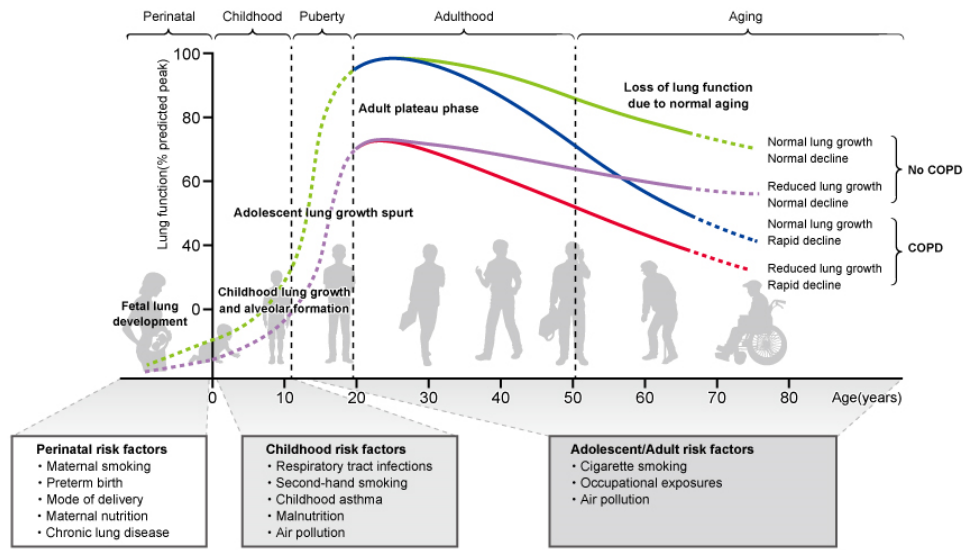
Figure 1. Patterns of growth and decline in lung function and risk factors leading to COPD.